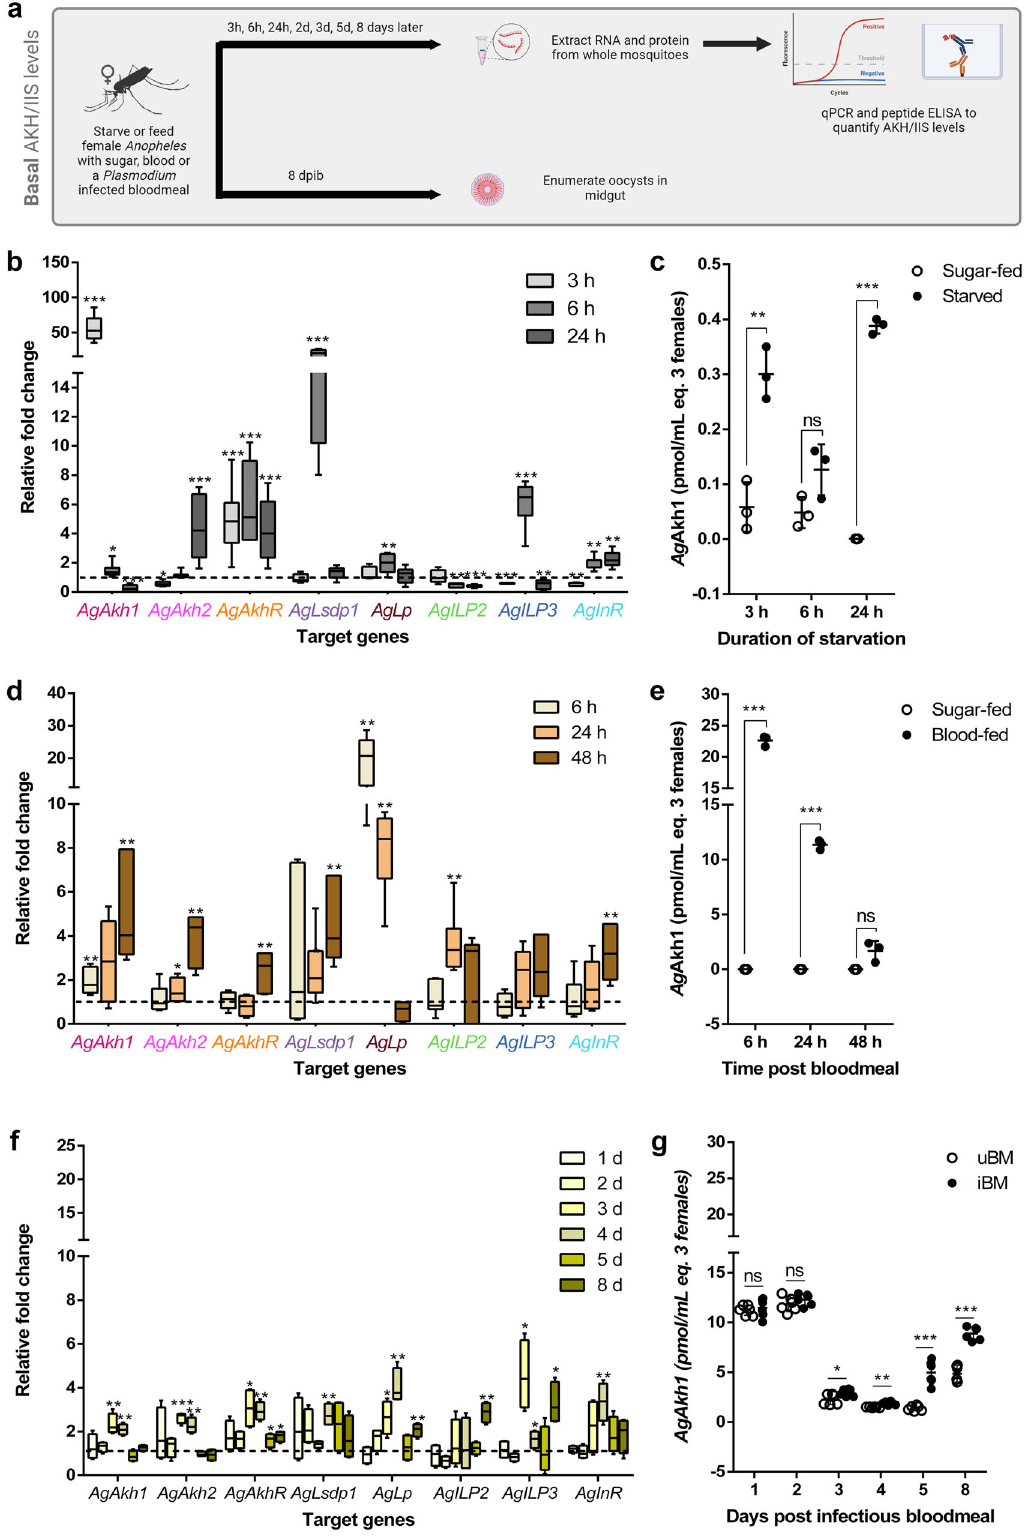
Plasmodium falciparum infection induces AKH signaling in An. gambiae . To understand how malaria parasite sporogony affects AKH signaling, we infected female An. gambiae (Keele strain) with P. falciparum (NF54 strain) and sampled at 1-, 2-, 3-, 4-, 5-, and 8-days postinfectious bloodmeal (dpib) to quantify AKH pathway transcripts (Fig. 1b (iii)). The time points